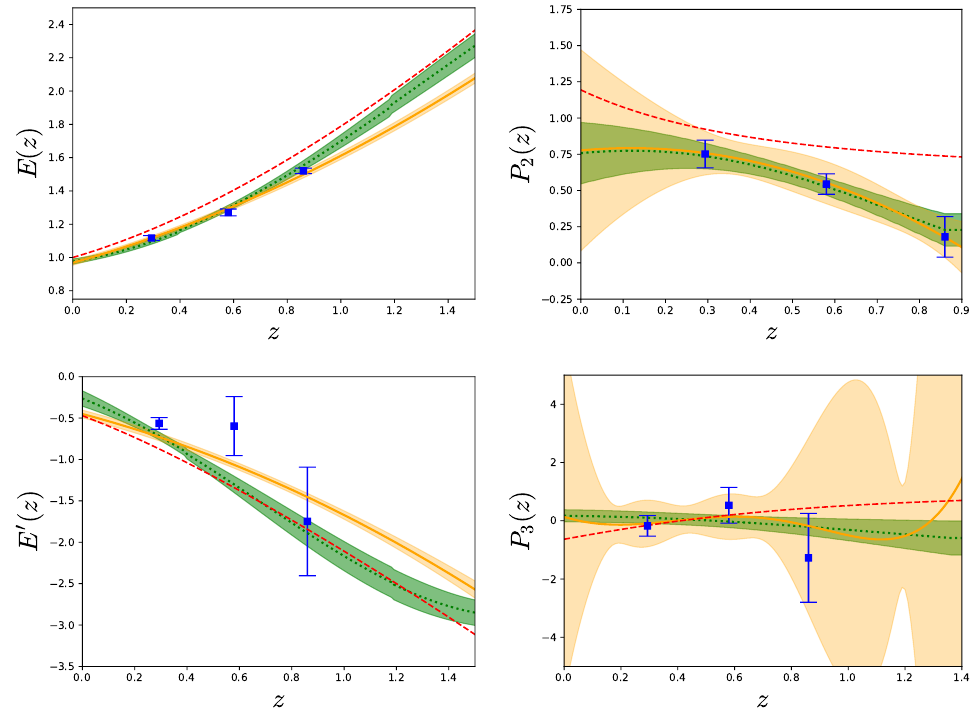
Figure 2. Comparison of the three reconstruction methods for each of the model-independent variables. The binning method is shown in blue squares with error bars, the Gaussian process is shown as a green dotted line with green bands, and polynomial regression is shown as a solid yellow line with yellow bands. All of them depict the 1 σ uncertainty. Left panel: Plot of the reconstructed E ( z ) function on the top and its derivative E (cid:48) ( z ) on the bottom. Right panel: Plot of the reconstructed P 2 ( z ) function on the top and the reconstructed P 3 ( z ) function on the bottom. For each case, we show the theoretical prediction of our reference Λ CDM model as a red dashed